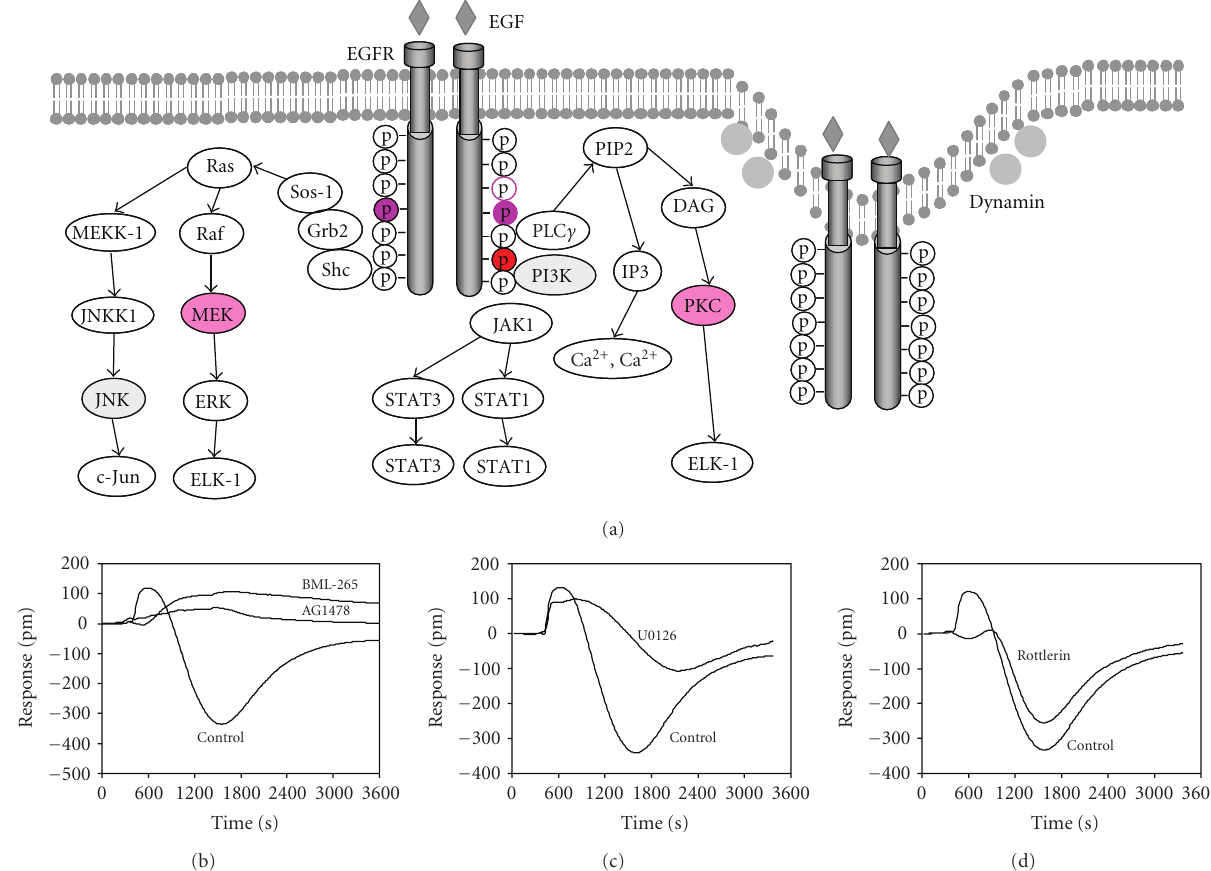
Figure 3: The DMR signal arising from epidermal growth factor (EGF) activated EGFR in native A431 cells is a systems cell biology readout of the EGFR. (a) Schematic drawing of EGFR signaling. (b, c, d) The sensitivity of the EGF DMR signal to di ff erent modulators, the two EGFR tyrosine kinase inhibitors AG1478 and BML-265 (b), the MEK1/2 inhibitor U0126 (c) and the PKC kinase inhibitor rottlerin (d). The control is the EGF response of cells pretreated with the assay vehicle only. In all experiments, EGF was at 32 nM, whereas the rest compounds used to pretreat the cells were at 10 μ